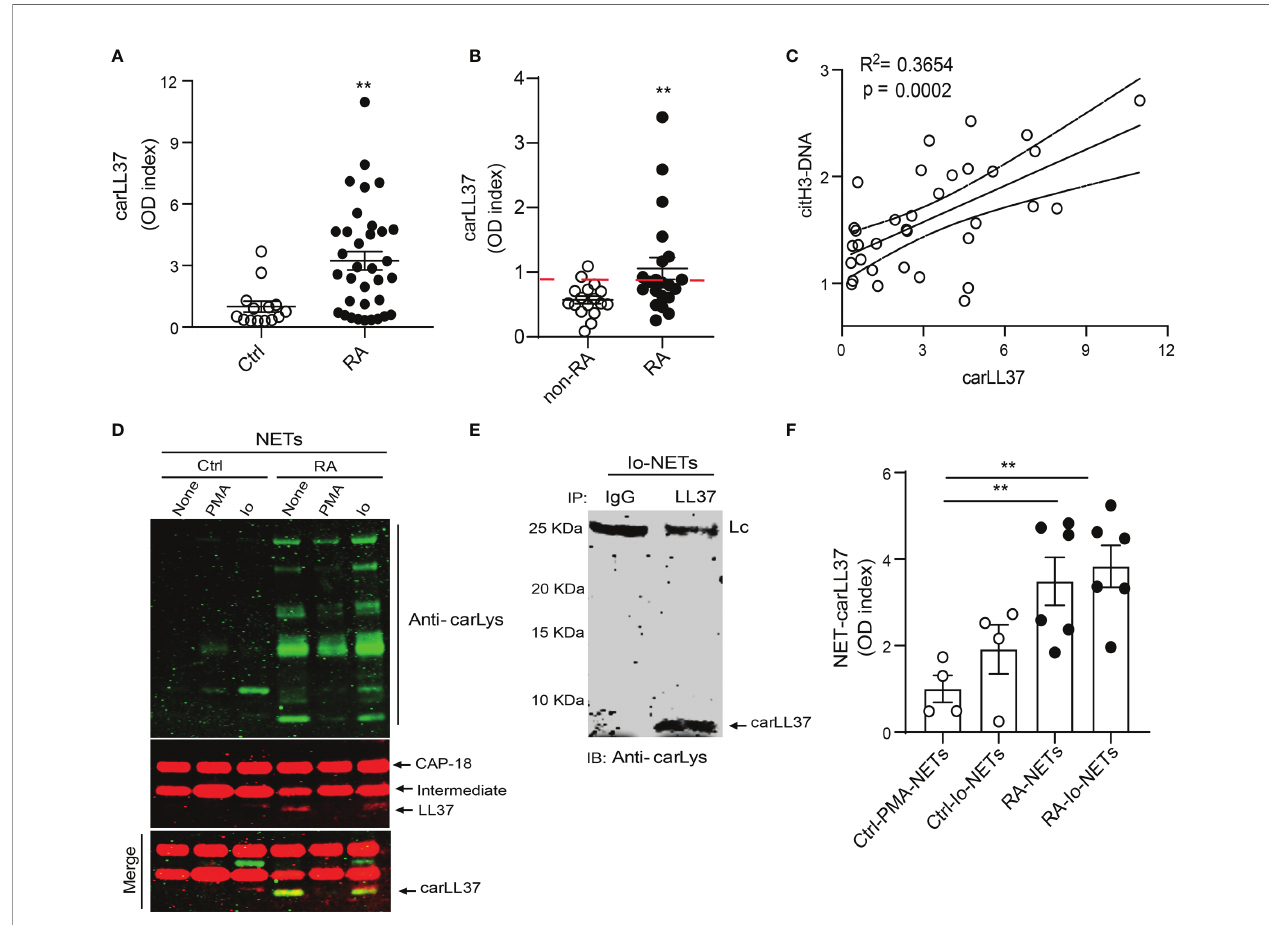
FIGURE 1 | Carbamylated LL37 is externalized in NETs and is elevated in RA serum and synovial fl uid. Carbamylated LL37 was measured in (A) serum from healthy controls (n = 25) and RA patients (n = 34) and (B) synovial fl uid (SF) from non-RA (n = 10) and RA (n = 17). Red dashed line = 2 standard deviations above mean for non-RA patients. (C) Citrullinated histone H3-DNA complexes correlate with levels of carbamylated LL37 in serum in RA (n = 34). (D) Western blot analysis of carbamylated proteins in NETs isolated from control or RA neutrophils in the presence or absence of PMA and ionophore (Io). Red: CAP18, intermediate and LL37, green: carbamylated lysine, yellow: carbamylated LL37. Bottom panel (merge) red bands are full length CAP18 and intermediate, yellow is carbamylated LL37 (E) Ionophore generated NETs were immunoprecipitated against LL37 and developed against carbamylation (carLys) by western blot. Lc is the light chain of the antibody used to immunoprecipitate. (F) Carbamylated LL37 was measured by ELISA in NETs isolated from control neutrophils stimulated with PMA or calcium ionophore (Io) or RA neutrophils in the presence or absence or calcium ionophore (Io). Results represent the mean +/- SEM unless otherwise stated. Mann-Whitney U test was used for between group comparisons. **p <